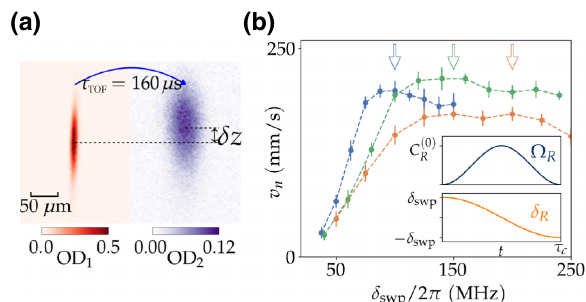
FIG. 3. (a) SDK momentum transfer measurement with a dou- ble imaging method: for atomic sample subjecting n SDKs ( n = 25 here) starting with ˜ U u ( k R ) ˜ U u ( − k R ) , a sequence of two absorption images are taken at ¯ t 1 = 10 μ s and ¯ t 2 = ¯ t 1 + t TOF , separated by τ TOF = 160 μ s time of flight and with a hyperfine repumping pulse along x applied in between (see main text). The center-of-mass position shift δ z is retrieved with a typical ± 2 μ m accuracy by fitting the optical depth (OD). The recoil veloc- ity v n = δ z /τ TOF is then estimated during typical adiabatic SDK parameter scan as in (b). Here, with n = 25, τ c = 60 ns SDK pulses applied, v n is optimized as a function of sweep frequency δ swp , and peak laser intensity parametrized by an estimated peak τ / 2. Blue, green, and orange lines Raman pulse area A R = C ( 0 ) c R correspond to estimated peak A R of approximately 6 π , 9 π , 12 π , are respectively. The corresponding peak Rabi frequencies C ( 0 ) R marked with arrows on the top along the δ swp axis. The error bars give statistical uncertainties of v n in repeated